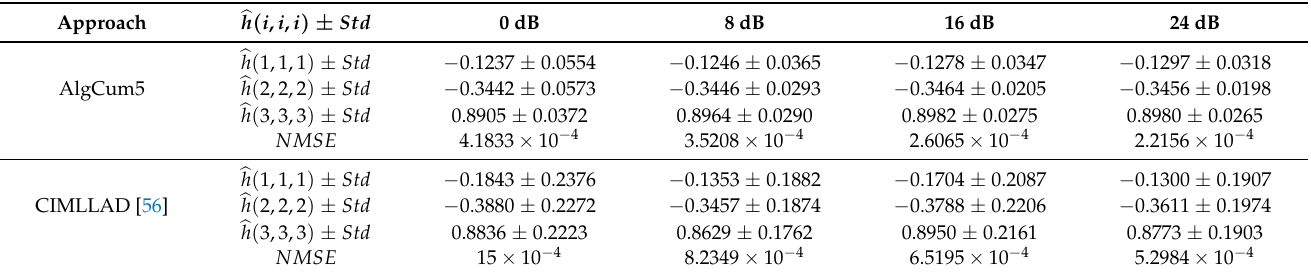
Table 1. True and estimated (means ± Std. Dev.) cubic kernels of the system I under 200 Monte Carlo